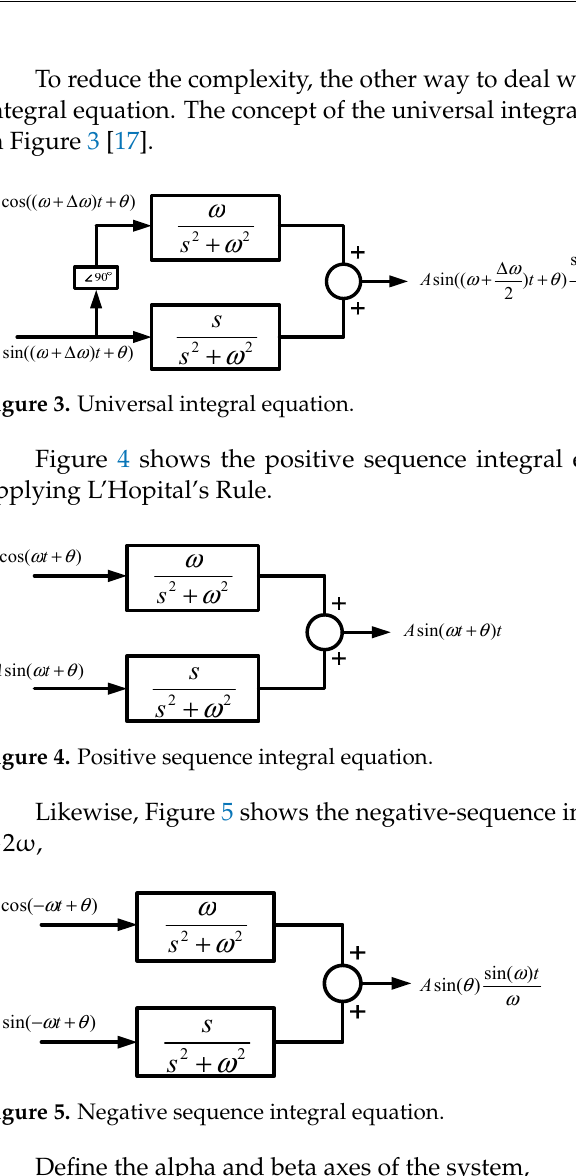
Figure 2. The conventional structure for unbalance component compensation.